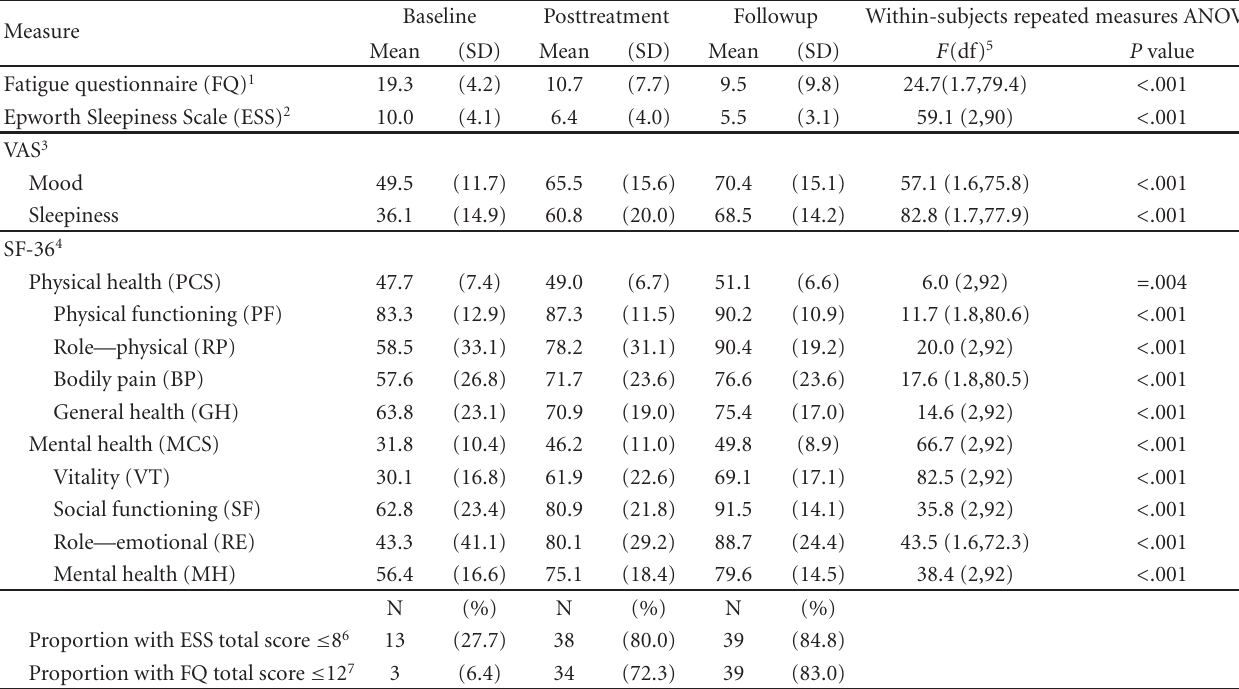
Table 1: Mean values (SD) for daytime sleepiness, fatigue, and quality of life in subjects with mild-to-moderate winter depressive mood at baseline, posttreatment, and at the one-month followup ( N = 47). Treatment refers to bright light therapy in a light room.